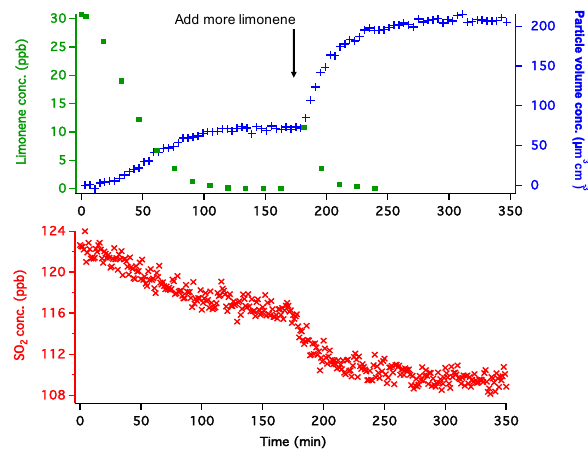
Figure 1. Particle volume concentration, limonene concentration and SO 2 concentration as a function of experimental time. After 105min, limonene concentration was below 1ppb, and particle vol- ume concentration and SO 2 concentration began to stabilize. At t = 170min, additional limonene was injected into the chamber, and particle formation and SO 2 decay resumed. The timescale of SO 2 consumption matches that of SOA formation, suggesting that there are synergistic effects between LSOA formation and SO 2